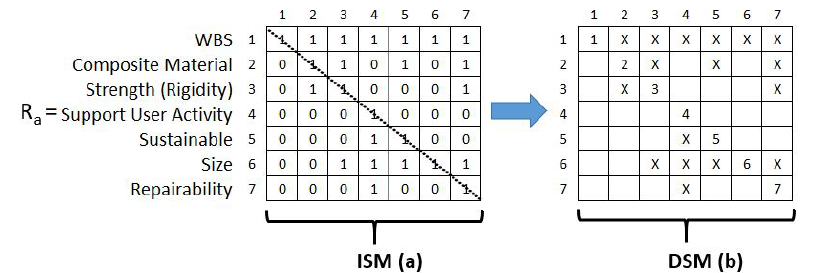
Figure 31. ISM Adjacency Matrix ( a ) is used to derive Design Structure Matrix (DSM) ( b ).